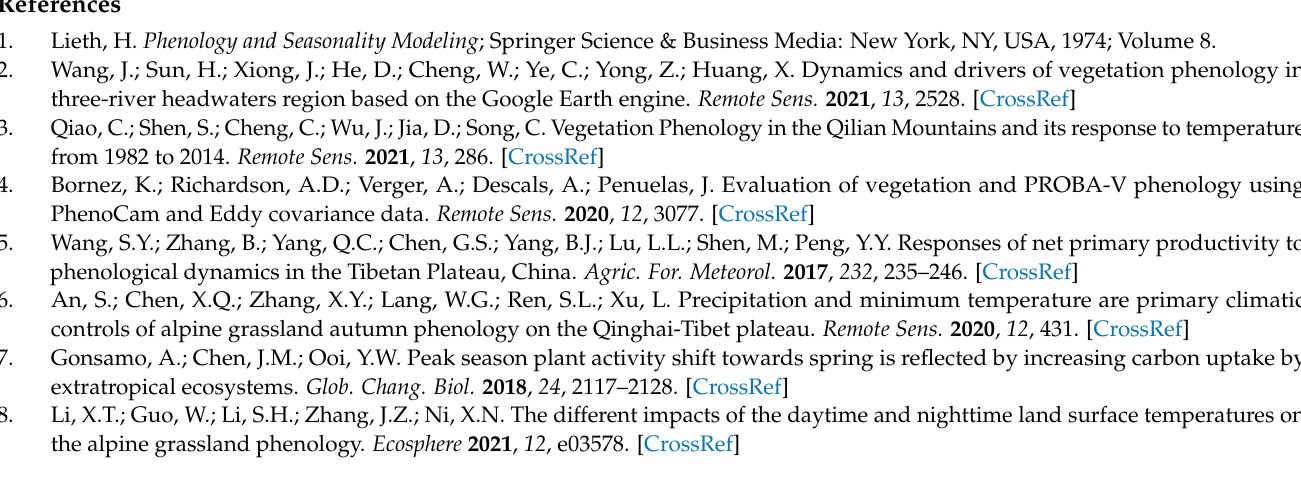
Figure A3. Relative influence of different climate variables (temperature, precipitation, and insolation) on EOS changes before ( a , e ) and after ( b , f ) the turning point, and over the entire study period ( c , g ) with the EOS values of HANTS and Polyfit methods respectively. ( d , h ) Area proportions controlled by the different dominant climate variables with results of HANTS and Polyfit methods.